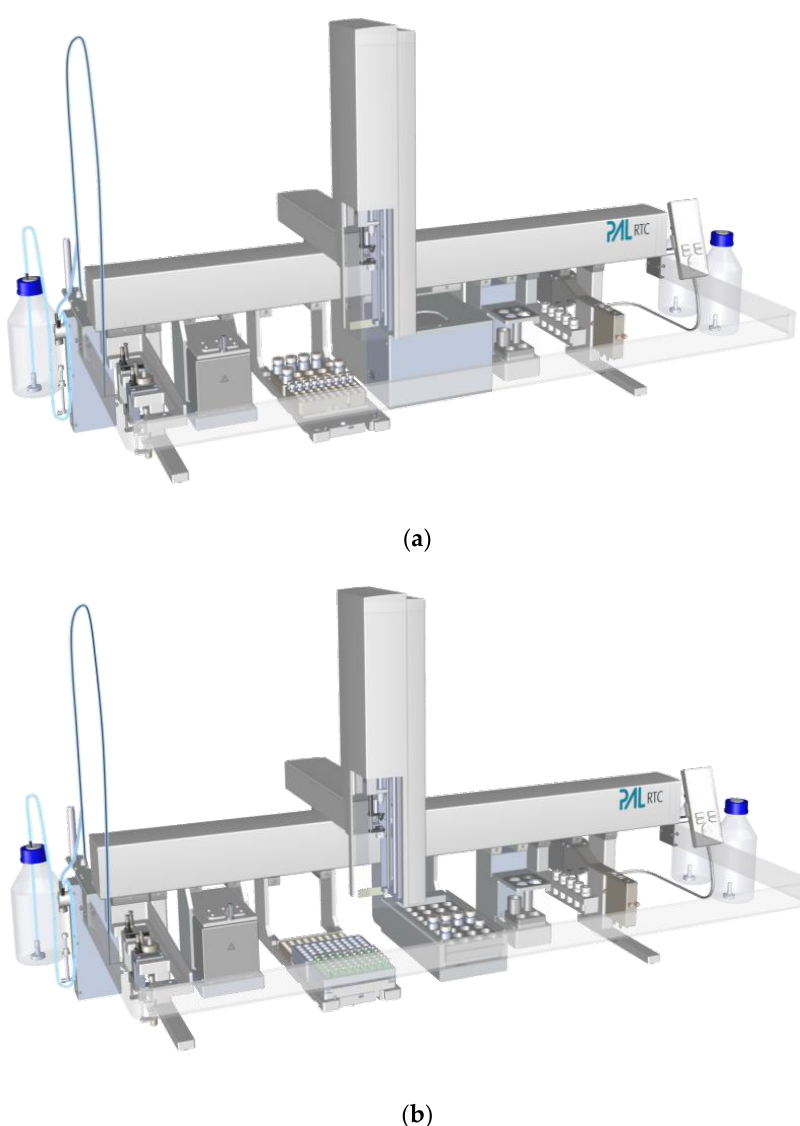
Figure 1. ( a ) Autosampler setup for LLE procedures: ATC with Dilutor, Agitator, Sample Rack, Centrifuge, Vortexer, Standard Wash Station and Fast Wash Station (left to right); ( b ) Autosampler setup for µ-SPE procedures: ATC with Dilutor, Agitator, µ-SPE Rack, Tray-Cooler, Vortexer, Standard Wash Station and Fast Wash Station (left to right).